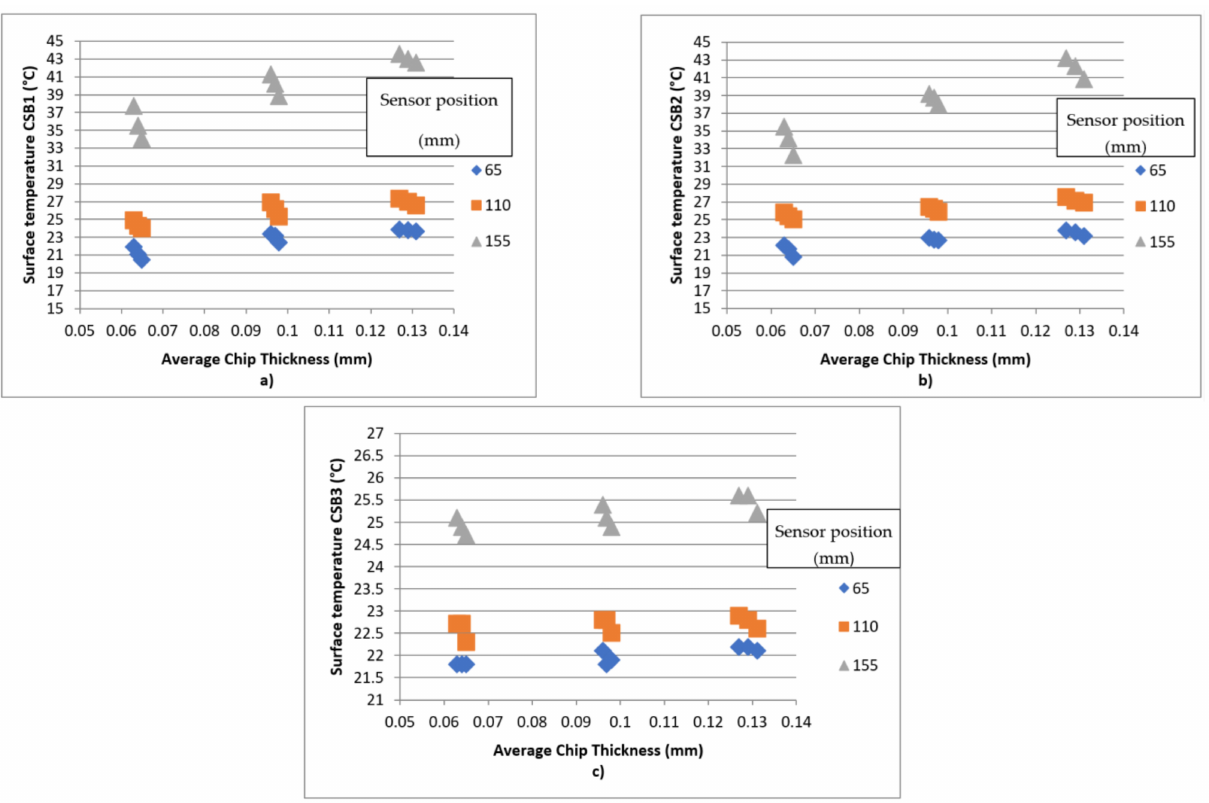
Figure 11. Influence of the average chip thickness on the surface temperature of the saw blade: ( a ) CSB1, ( b ) CSB2, and ( c ) CSB3. Comparison of Figure 10 (a) CSB1, (b) CSB2, and (c) CSB3 in terms of the